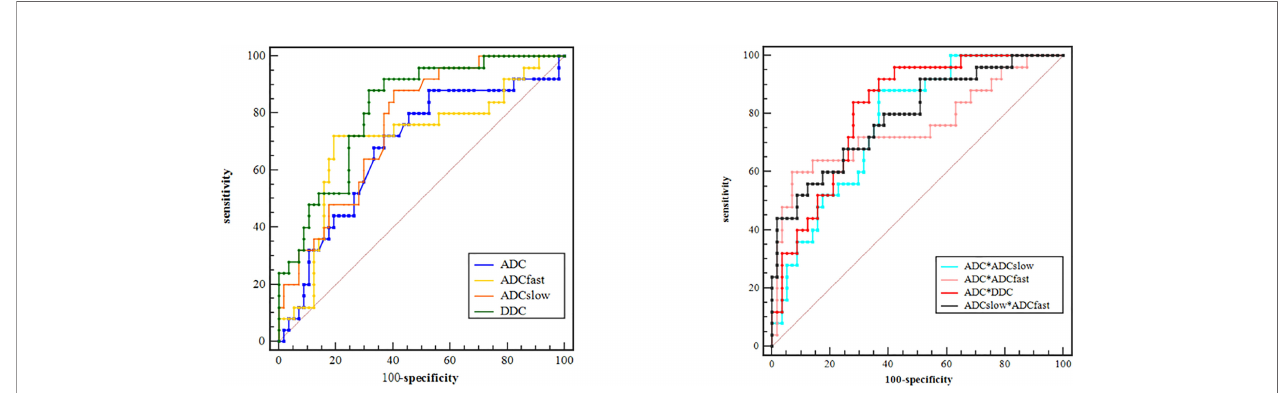
FIGURE 4 | ROC curves of different parameters for identifying PD (poorly differentiated) group with WD/MD (moderately/well-differentiated) group of